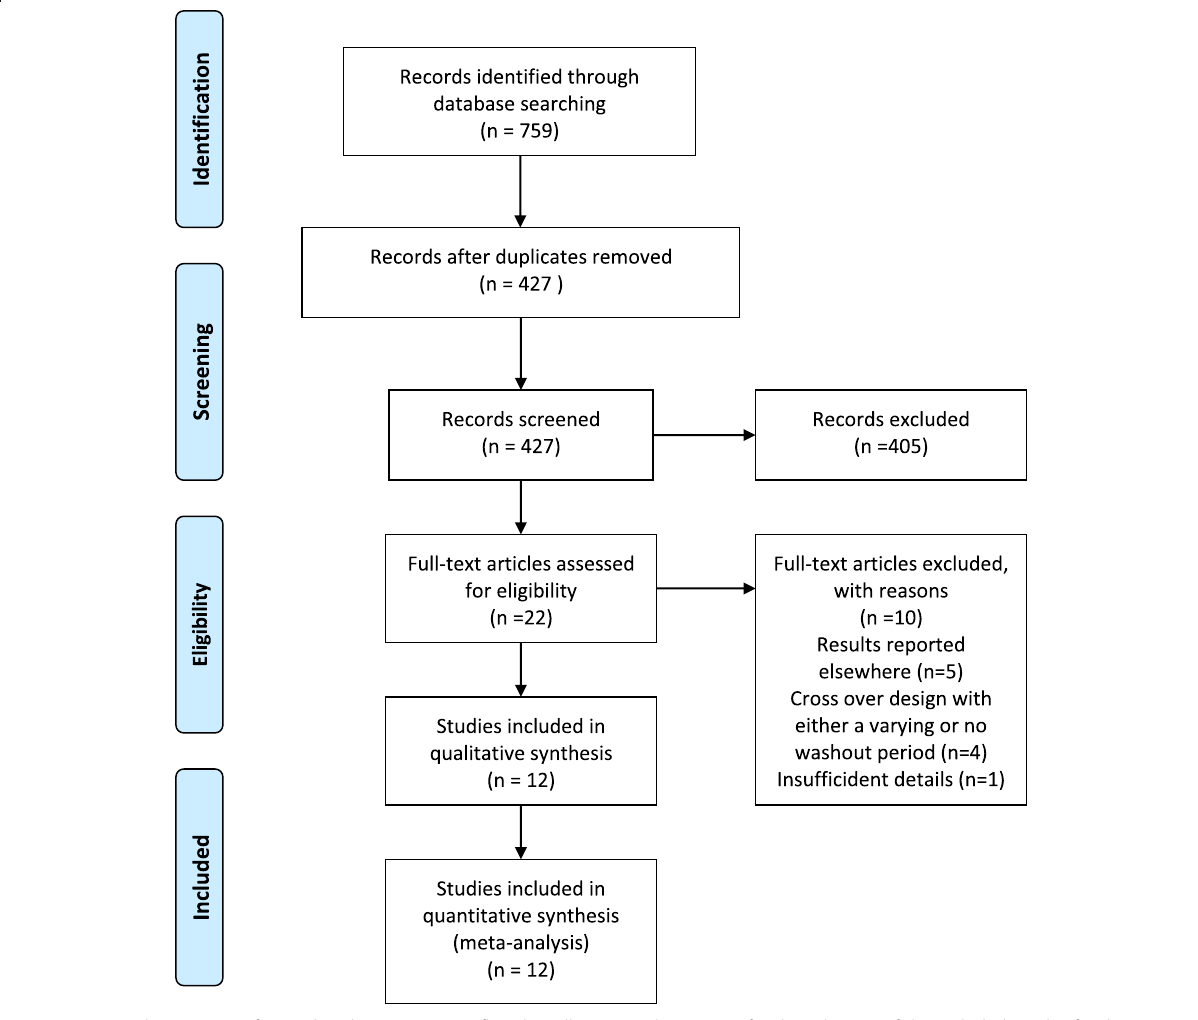
Fig. 1 PRISMA Flow Diagram for Study Selection. PRISMA flowchart illustrating the process for the selection of the included articles for the systematic review and for the data synthesis of the randomized controlled clinical trials of enteric-coated peppermint oil versus placebo in patients with irritable bowel syndrome (IBS). Inclusion: Adult patients (18 years or greater) with IBS as diagnosed using any of the following criteria for IBS: Manning Criteria, Rome I, II, III, IV diagnostic criteria who were randomized to enteric-coated peppermint oil or placebo for a minimum of two weeks. Exclusion: Patients having an organic disease or who had not had an organic disease were excluded. Non-randomized trials; observational studies such as cohort study, cross-sectional study, etc.. A detailed evaluation of the articles by at least two independent reviewers (total of three) assessed the sufficiency of data and relevance to the topic. Seven hundred and fifty-nine articles were identified using PubMed ( n = 102)/EMBASE ( n = 396)/Cochrane ( n = 60)/Web of Science ( n = 201) search engines. After de-duplication, 427 records were screened and 22 deemed suitable for full-text review. Ten articles were eliminated, thus leaving twelve for qualitative and data